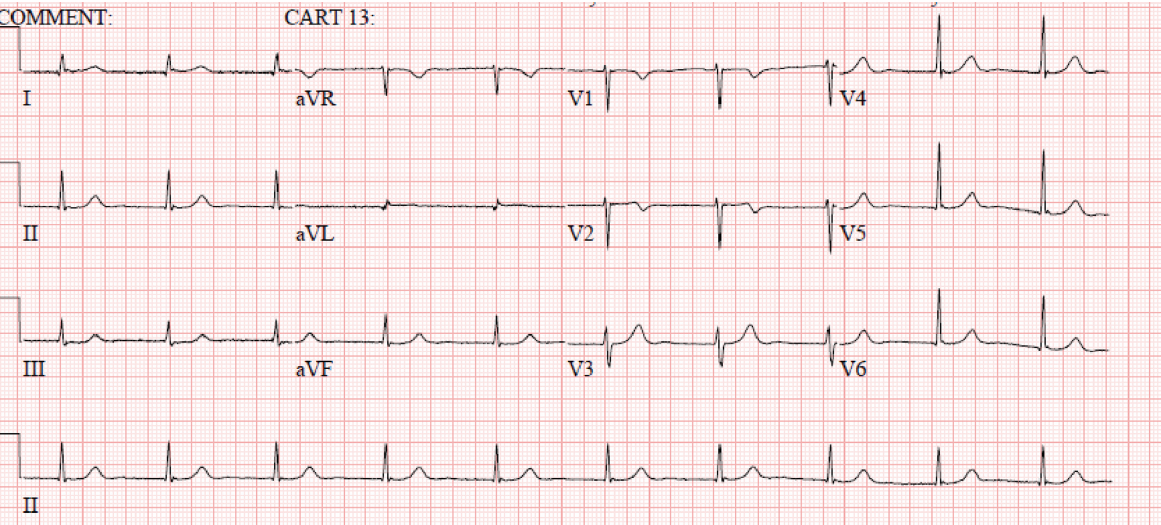
Figure 2: ECG obtained on day 3 exhibiting a heart rate of 60 bpm, a junctional rhythm, normal axis, and Twave inversions in V1 and V2.